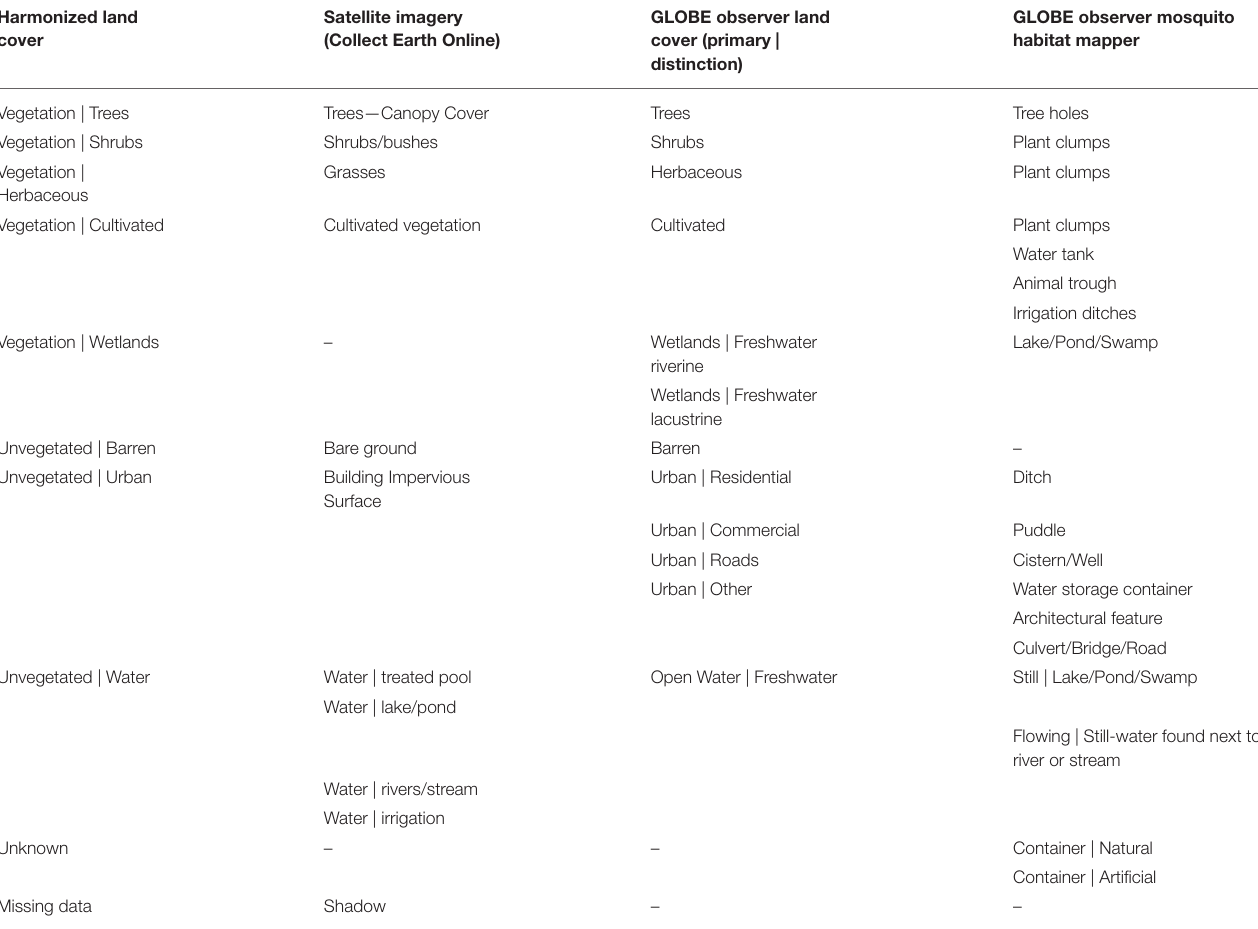
TABLE 1 | Overview of land cover element attributes used in the three different citizen science tools. Harmonized land